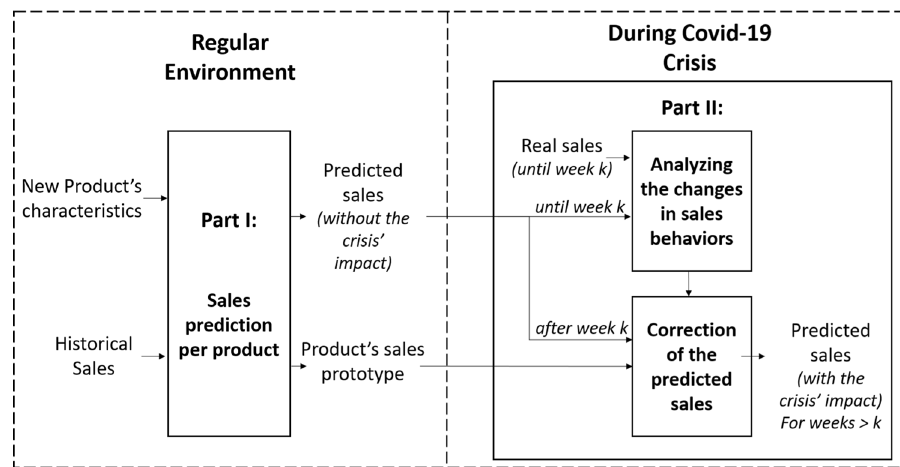
Fig. 2 Overview of the pro- posed